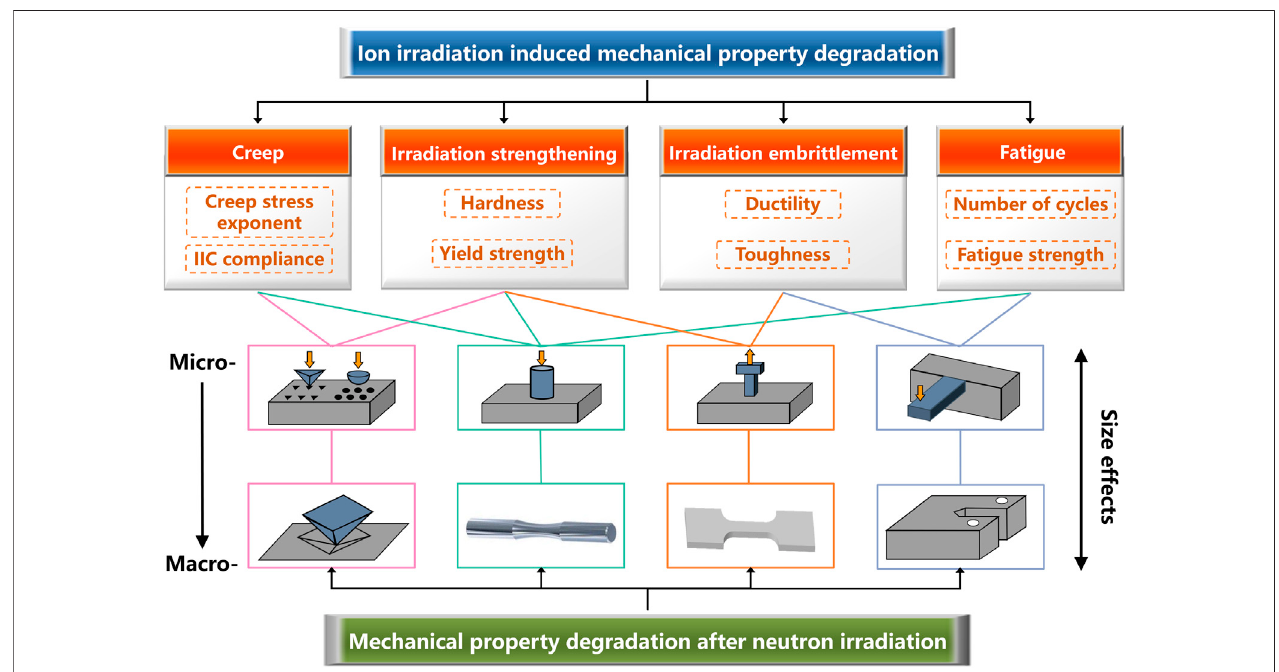
FIGURE 1 | The small-scale and macroscale mechanical property tests to evaluate the irradiation induced mechanical property degradation.